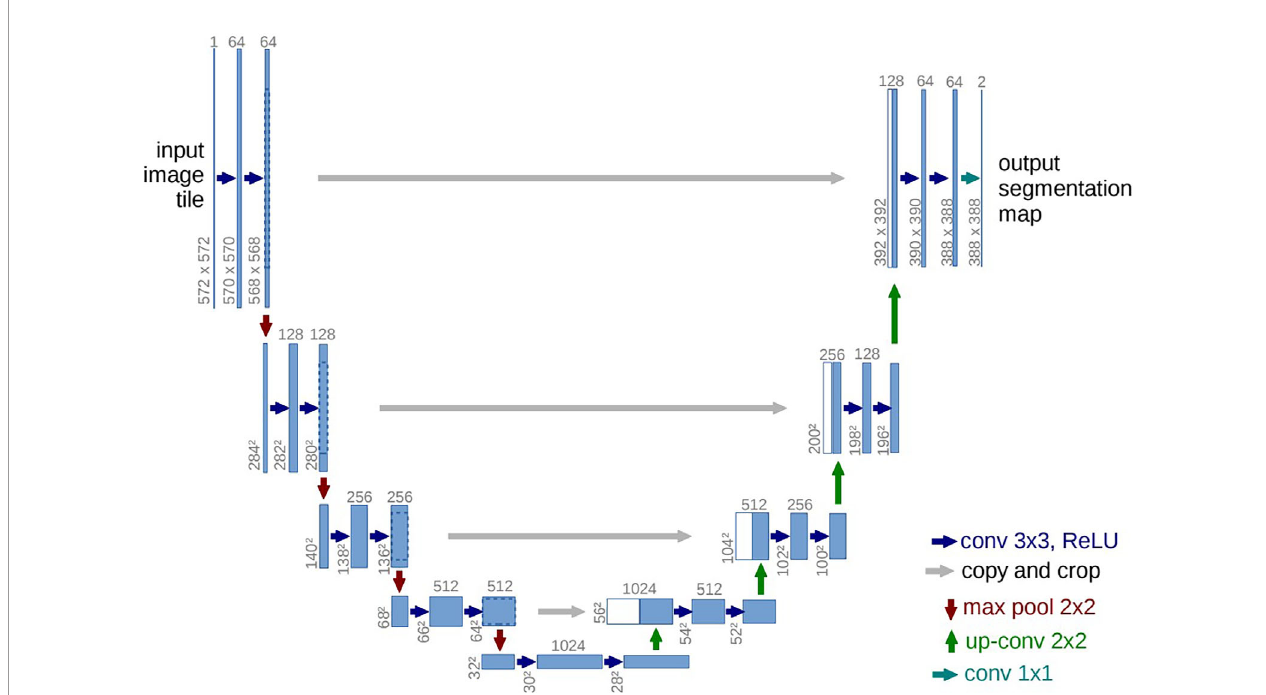
FIGURE 3 | Architecture of a conventional U-Net (46). The blue boxes represent multi-channel feature maps, and the white boxes correspond to the copy of feature maps in the encoder branch. The arrows of different colors represent various operations. The number provided on the top of the box represents the number of channels, and the x-y-size of feature map is denoted at the lower left edge of the